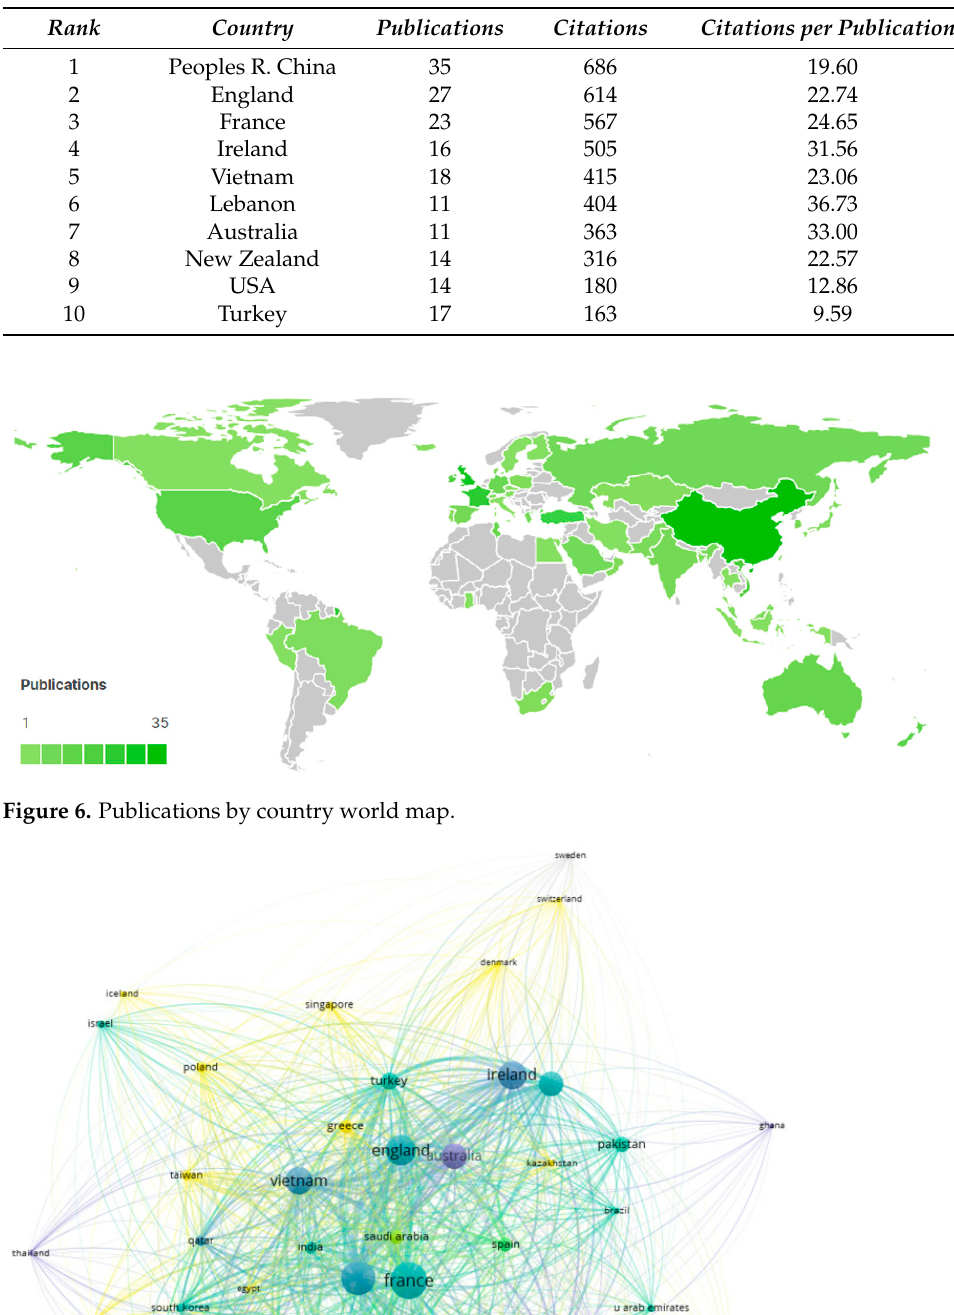
Figure 7. Normalized citations of countries by year. 4. Literature Findings on Portfolio Diversification, Hedge and Safe-Haven Properties of Cryptocurrency Investments 4.1. Do Cryptocurrencies Bear Hedging Properties? This literature review addresses the hedging properties of cryptocurrencies. In this strand of literature, we found evidence that supports the hedging ability of cryptocurren- cies against stocks (Fang et al. 2020; Kumah and Odei-Mensah 2021), fiat currencies (Hsu et al. 2021; Kinkyo 2020), Gold (González et al. 2021; Hsu et al. 2021; Kumah and Mensah